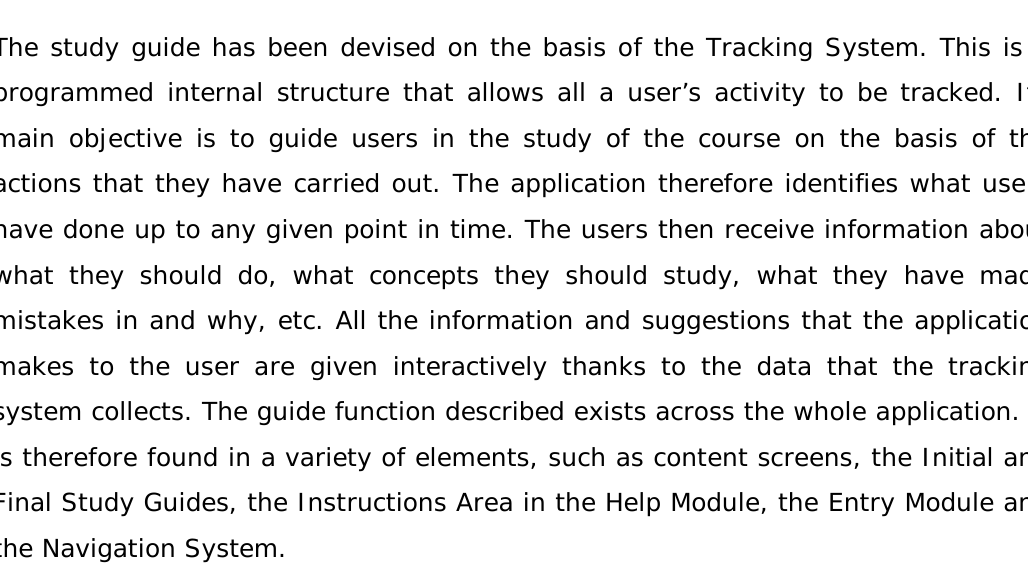
Figure 4. “Example of